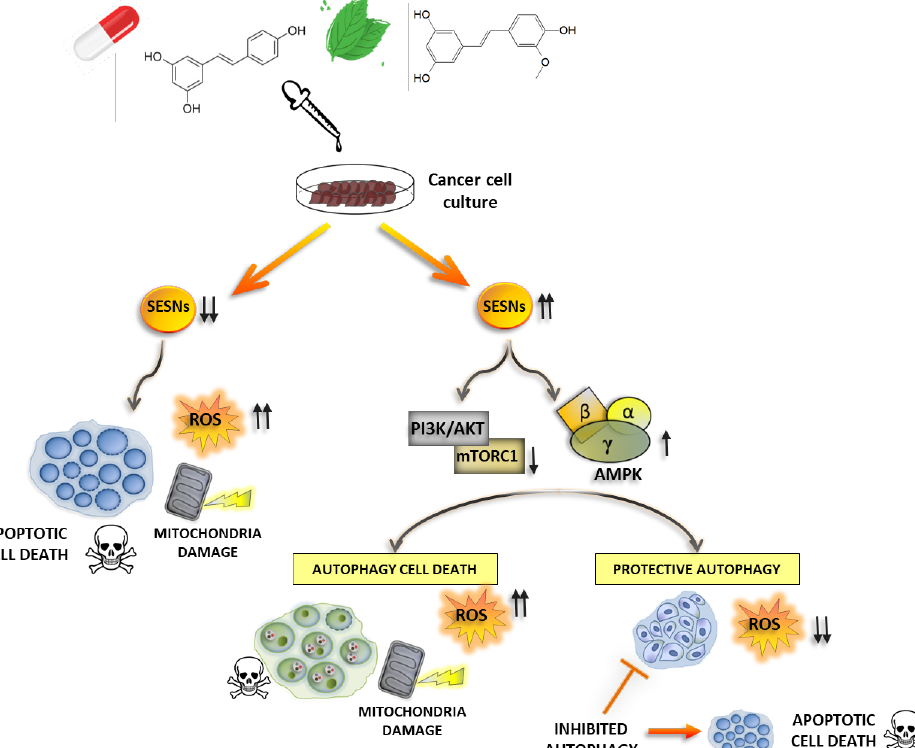
Figure 3. Sestrins (SESNs) as a therapeutical management of cancer. Natural compounds or synthetic therapeutics lead to changes in SESNs expression in a manner dependent on the type of drug, the target tissue and the metabolic status of cancer cells. Enhanced SESNs expression might result in autophagy activation, leading alternatively to cell death or survival in cancer cells, depending on the differentially induced autophagic program. Some drugs may also reduce sestrins expression in cancer cells, leading to ROS enhancement, mitochondria damage and apoptotic cell death.